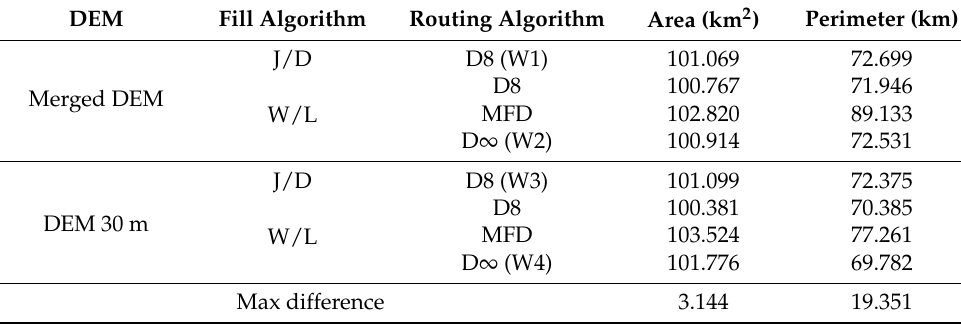
Table 6. Watershed area and perimeter calculation.